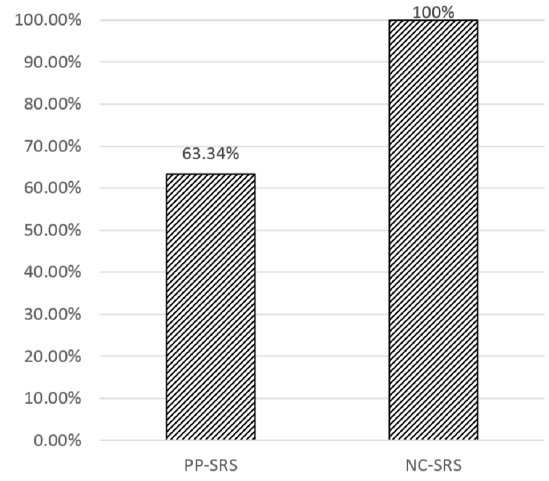
Figure 13. Service provision rate of PP-SRS and NC-SRS.